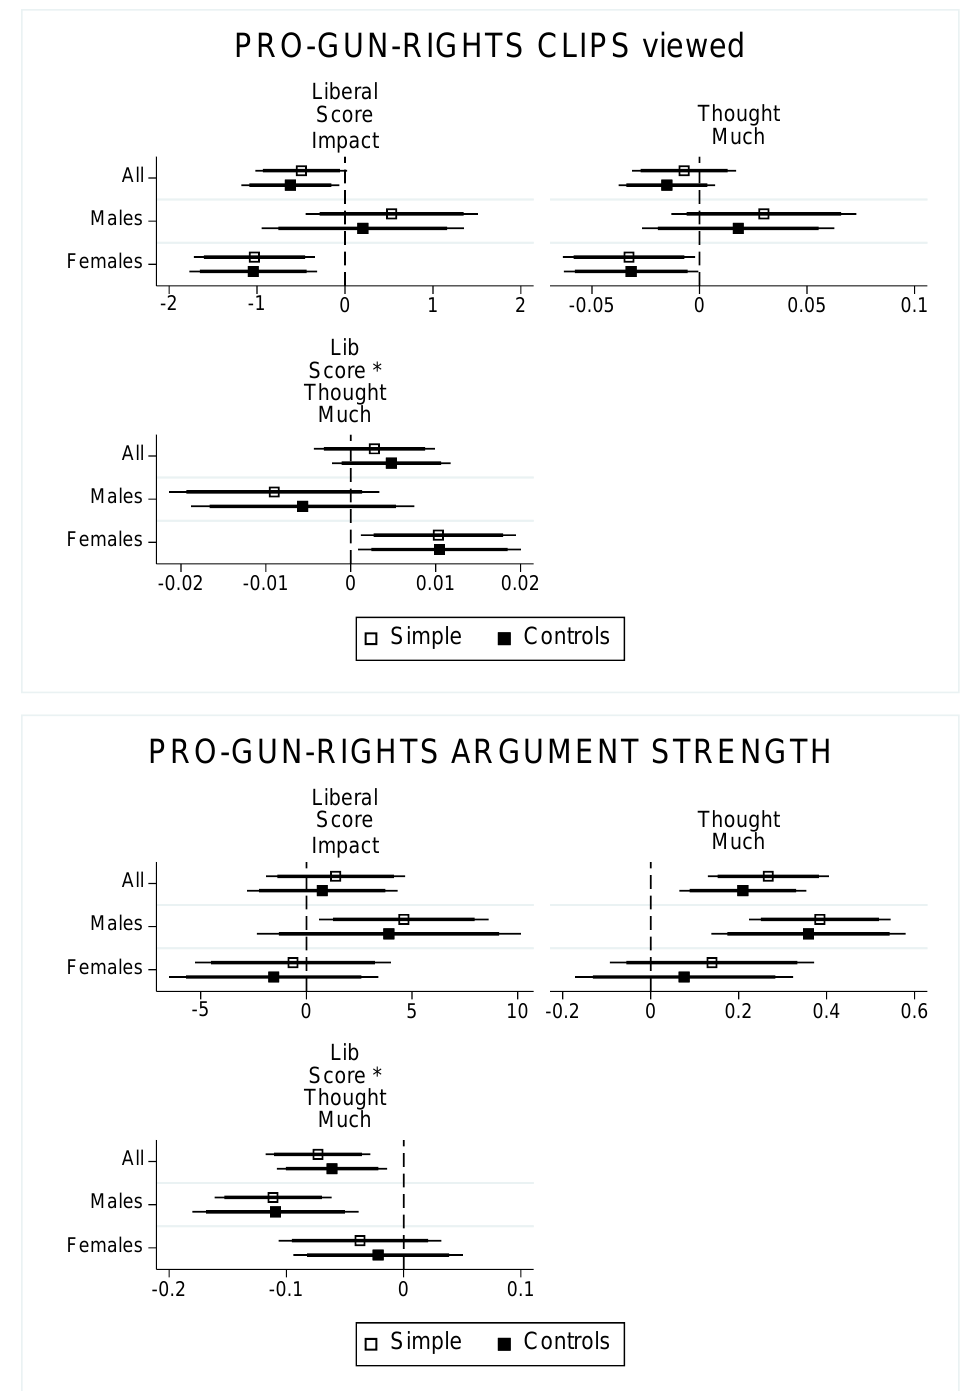
Figure A4. Examining Thought Much direction as a regressor (with Liberal Score interaction). Notes: Simple models restricted analysis to SR compliant participants and accounted for sample selection using the IPW correction. These simple models included only the regressors whose coe ffi cient estimates are shown above. “Controls” models additionally included full set of control variables (age, gender (for the “All” sample), minority status, Epworth (daytime) sleepiness score, morningness-eveningness preference (rMEQ), SR assignment, prosociality, backwards induction skill, and cognitive reflection score.) Thin (thick) lines around point estimates represent the 95% (90%) confidence intervals. Full estimation results available on